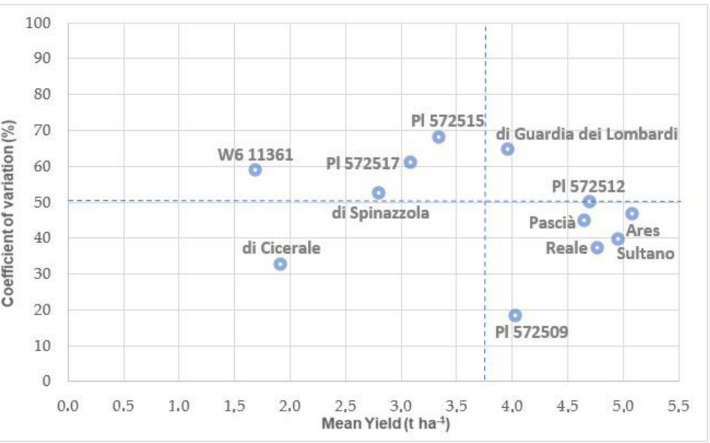
Figure 5. Mean SY (t ha − 1 ) plotted against the CV as a percentage for the 12 chickpea accessions. Dashed lines represent the average yield (vertical) and the CV across all the accessions (horizontal).